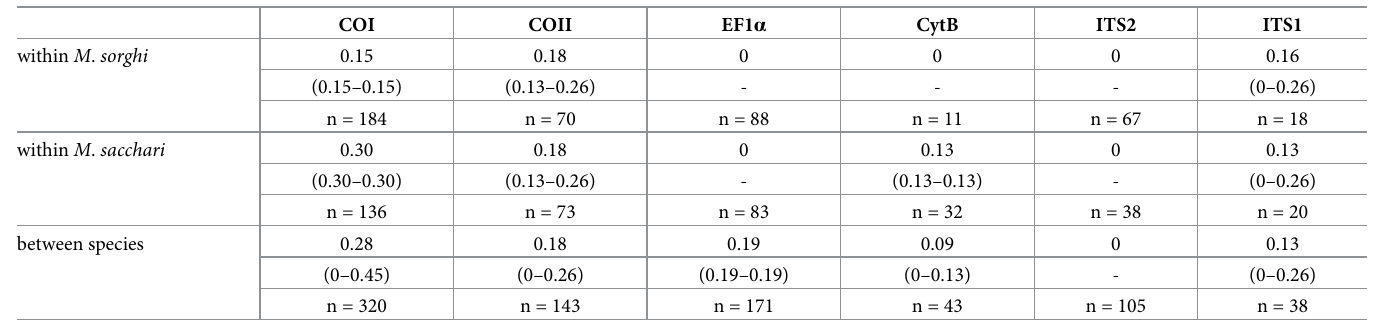
Values are the mean of the pairwise distances; minimum and maximum distances for these comparisons are given in parentheses. Number of genotyped specimens = n. Species identification was carried out by SSR genotyping on the specimens themselves or on other specimens from the same